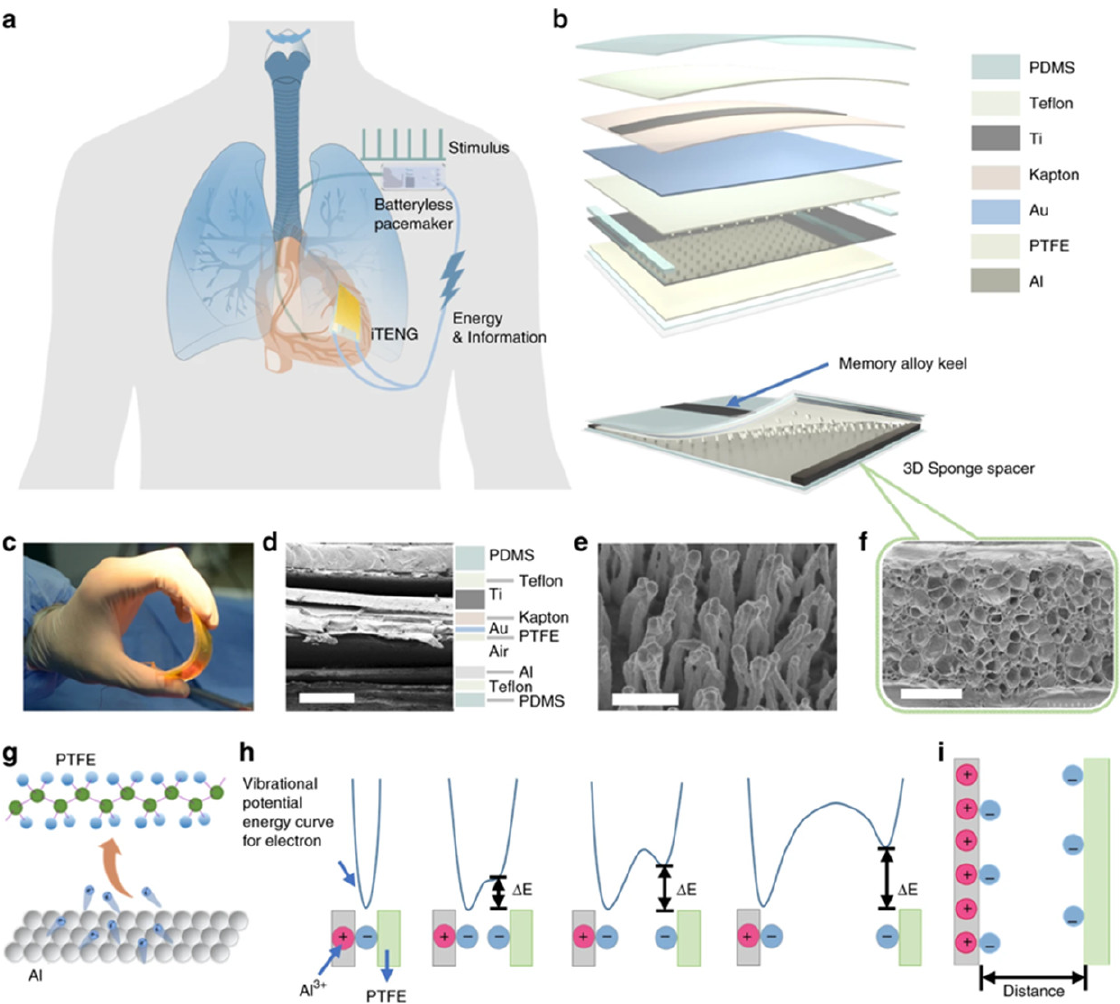
Figure 15. Schematic view of main components of symbiotic pacemaker system developed by Ouyang et al. [110]. ( a ) Schematic representation of different elements used in the symbiotic cardiac pacemaker system. ( b ) Illustration of the materials used in the iTENG. ( c ) Image of the iTENG structure under bending stress. ( d ) SEM image of different layers of an iTENG section (scale bar: 500 mm). ( e ) SEM image of the nanostructure on the PTFE layer (scale bar: 1 mm) of the iTENG. ( f ) SEM image of a 3D elastic sponge structure (scale bar: 500 mm). ( g , h ) Schematic view of the mechanism of charge transfer. ( i ) Model of the charge separation caused by the charge transfer. Reprinted with permission from [110]. Copyright 2019, Springer Nature.